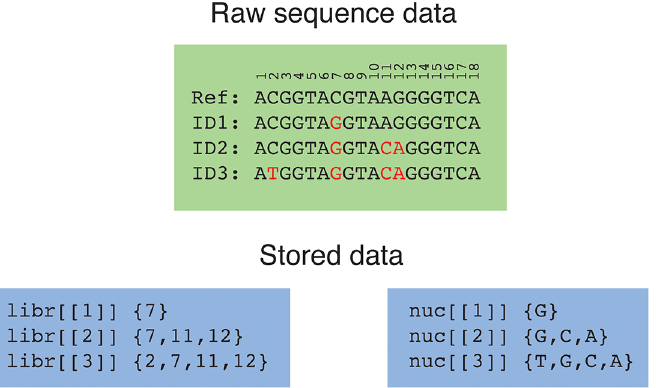
Fig 1. Raw sequence data and its storage in seedy . The ‘ libr ’ object stores the position of the mutant nucleotide, while the ‘ nuc ’ object lists the type of